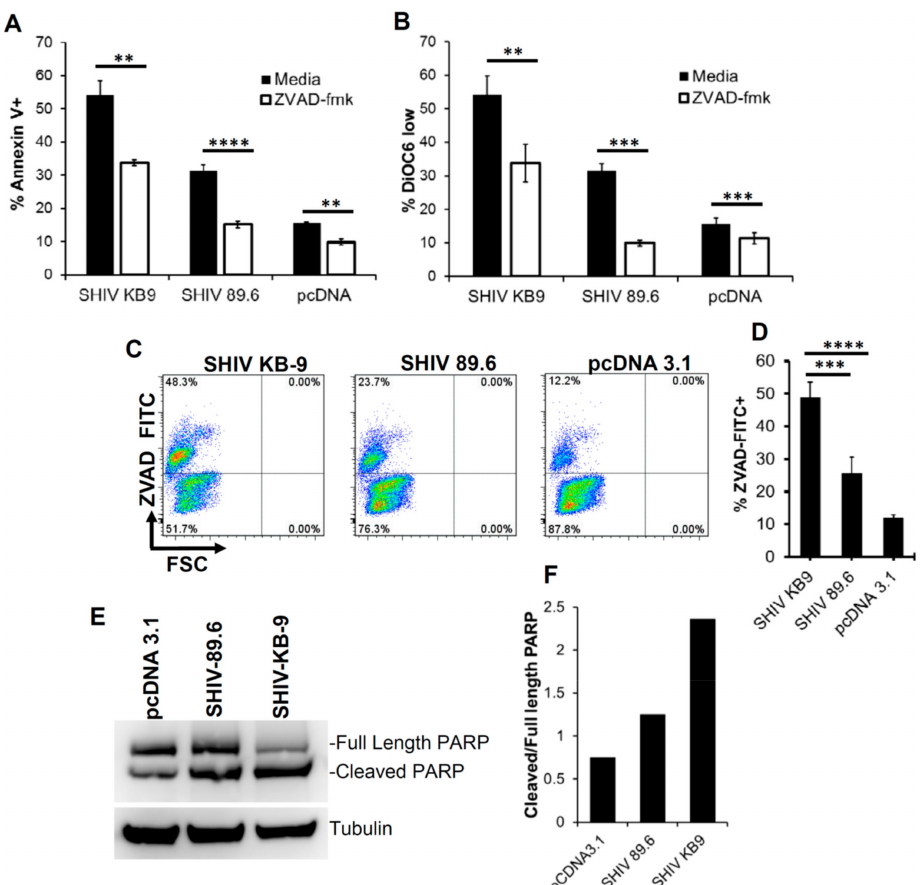
Figure 6. Bystander apoptosis mediated by SHIV KB9 is caspase dependent. HeLa cells expressing SHIV Env were cocultured with SupT cell in the presence or absence of pan caspase inhibitor ZVAD-fmk. Apoptosis was detected 24 h later using Annexin V ( A ) or DiOC6 staining ( B ). **** = p ≤ 0.0001; *** = p ≤ 0.001; ** = p ≤ 0.01 as determined by two tailed unpaired t-test. Activation of caspases in HeLa Env-SupT cocultures was detected by staining with ZVAD-FITC. Representative dot plots are shown ( C ) and data from triplicate observations is shown in ( D ). **** = p ≤ 0.0001; ** = p ≤ 0.01 as determined by one-way ANOVA followed by Dunnett’s multiple comparison test. PARP cleavage was detected in SupT cells cocultured with HeLa cells transfected with di ff erent SHIV Envs or control vector. Western blot of PARP protein levels and tublin control is shown in ( E ). Quantitation of PARP cleavage as ratio of cleaved PARP / total PARP is shown in ( F